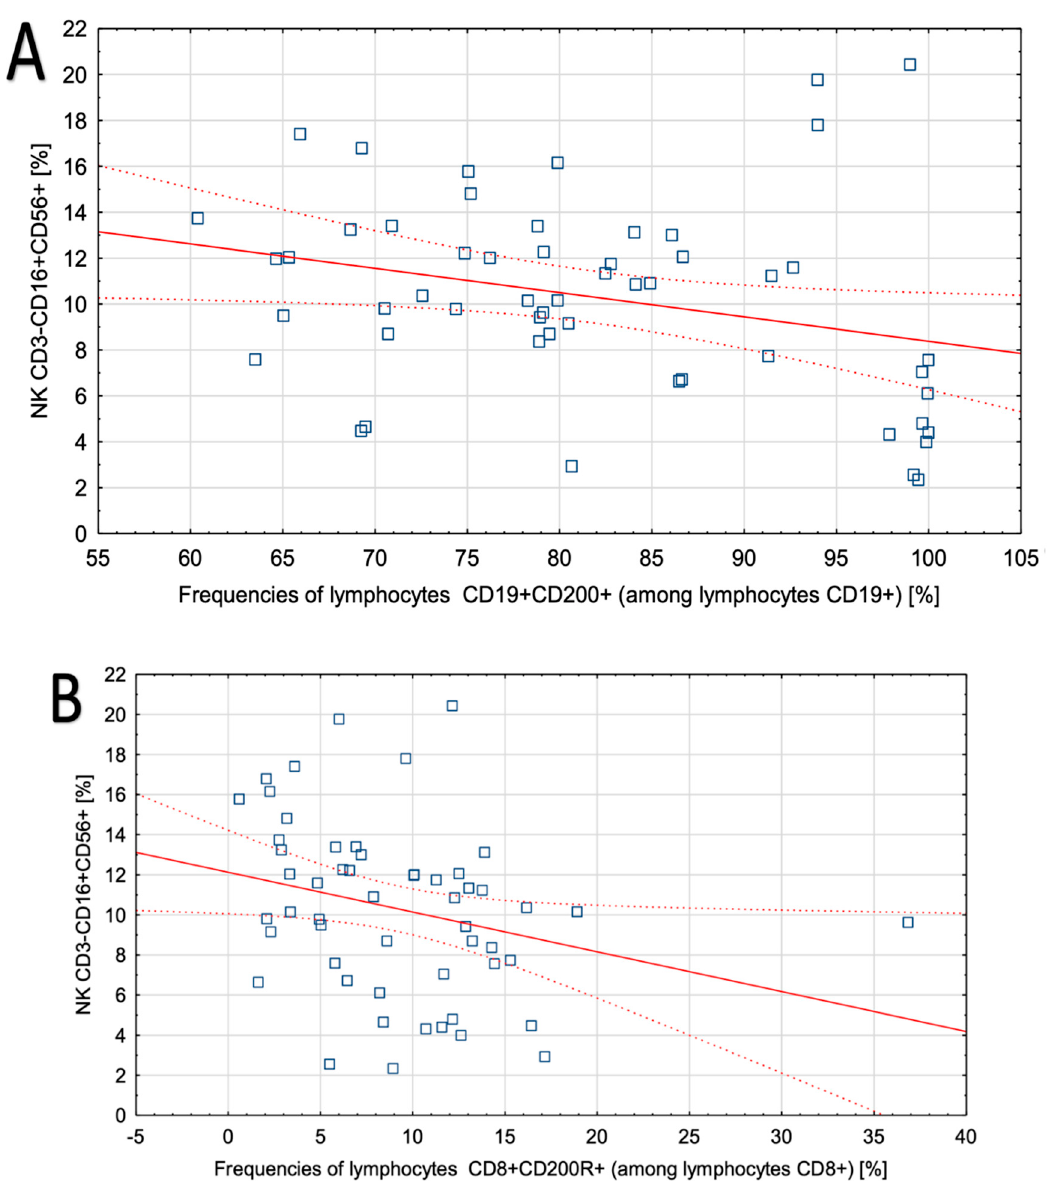
Figure 1. Correlations between the expression of CD200 and CD200R and selected laboratory parameters in patients with the EMS. Spearman correlation coefficients: ( A ) Correlation between the frequencies of CD19+/CD200+ B lymphocytes and CD3+/CD16+/CD56+ NK cells (Pearson’s correlation coefficient; R = − 0.33, p = 0.013); ( B ) correlation between the frequencies of CD8+/CD200R+ T lymphocytes and CD3+/CD16+/CD56+ NK cells (R = − 0.36, p = 0.007).